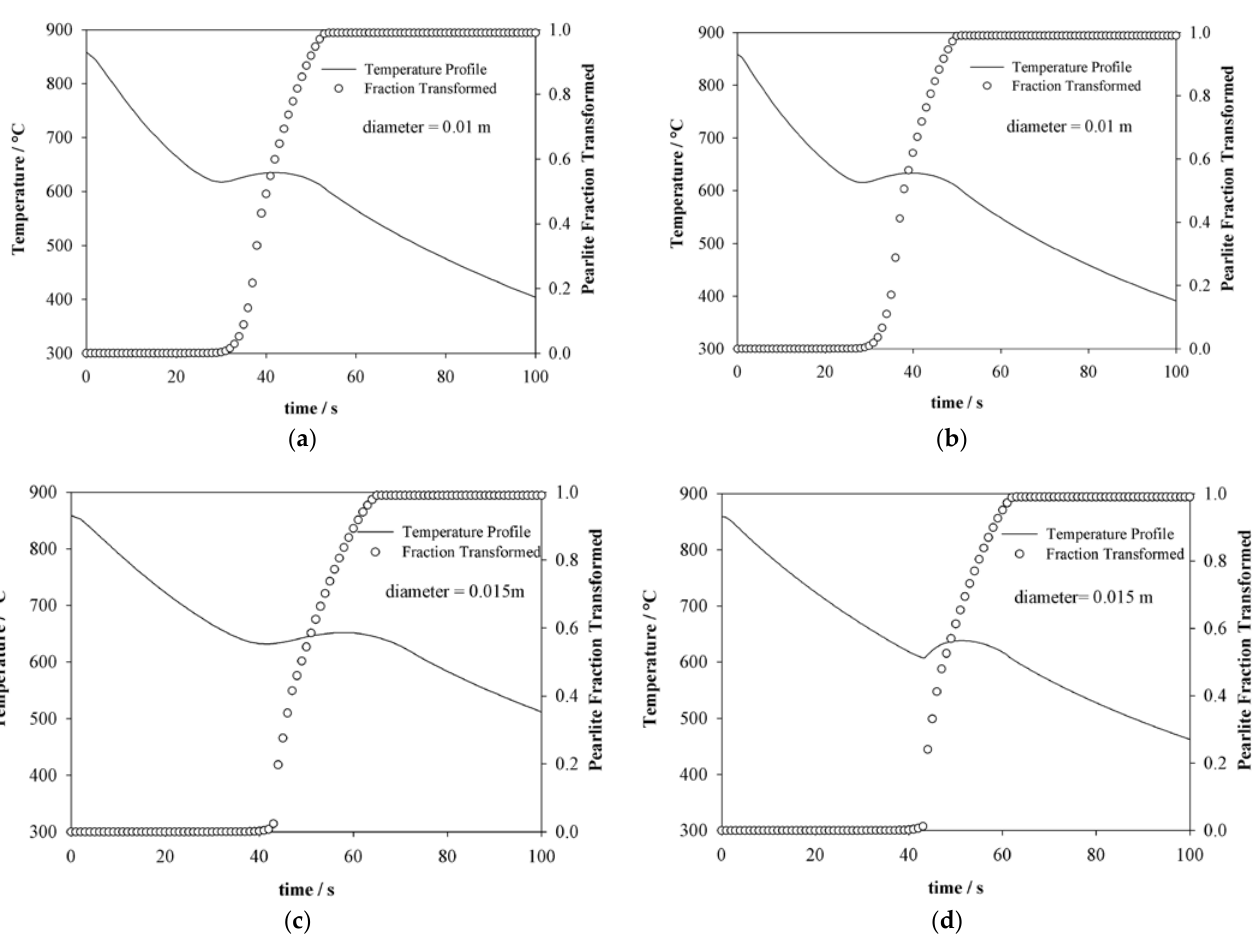
Figure 5. Microstructural evolution of the pearlite superimposed on the estimated thermal history for each of the specimens varying the diameter and air velocity, for ( a ) specimen 1; ( b ) specimen 2; ( c ) specimen 3; and ( d ) specimen